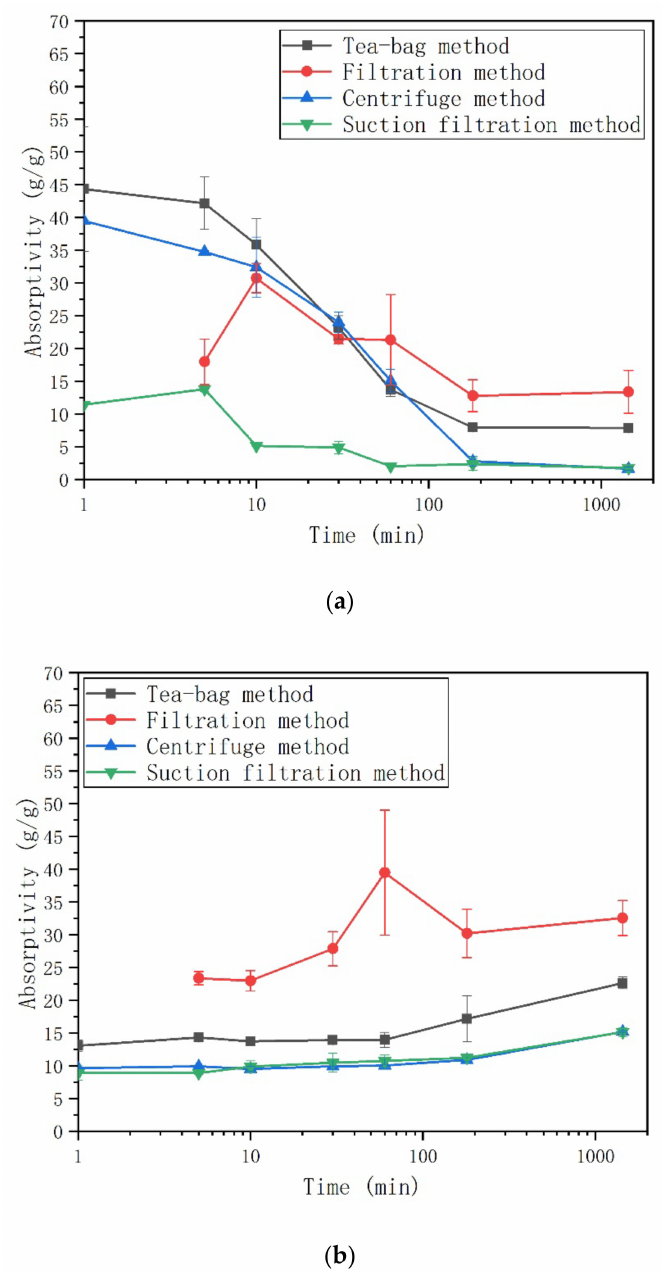
Figure 6. Development of SAP absorption in cement filtrate measured with di ff erent methods: ( a ) anionic SAP A73 and ( b ) AM-based SAP